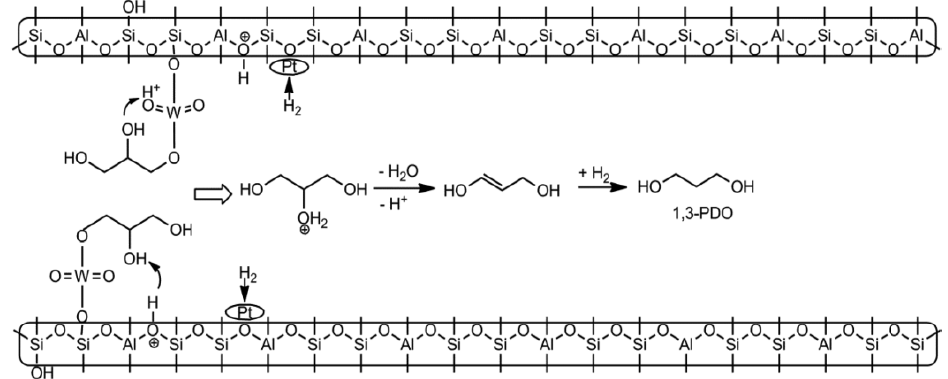
Figure 19. The reaction mechanism on the Pt/W+Al/SBA-15 catalyst. Reproduced from [107] with permission from the American Chemical Society (ACS).